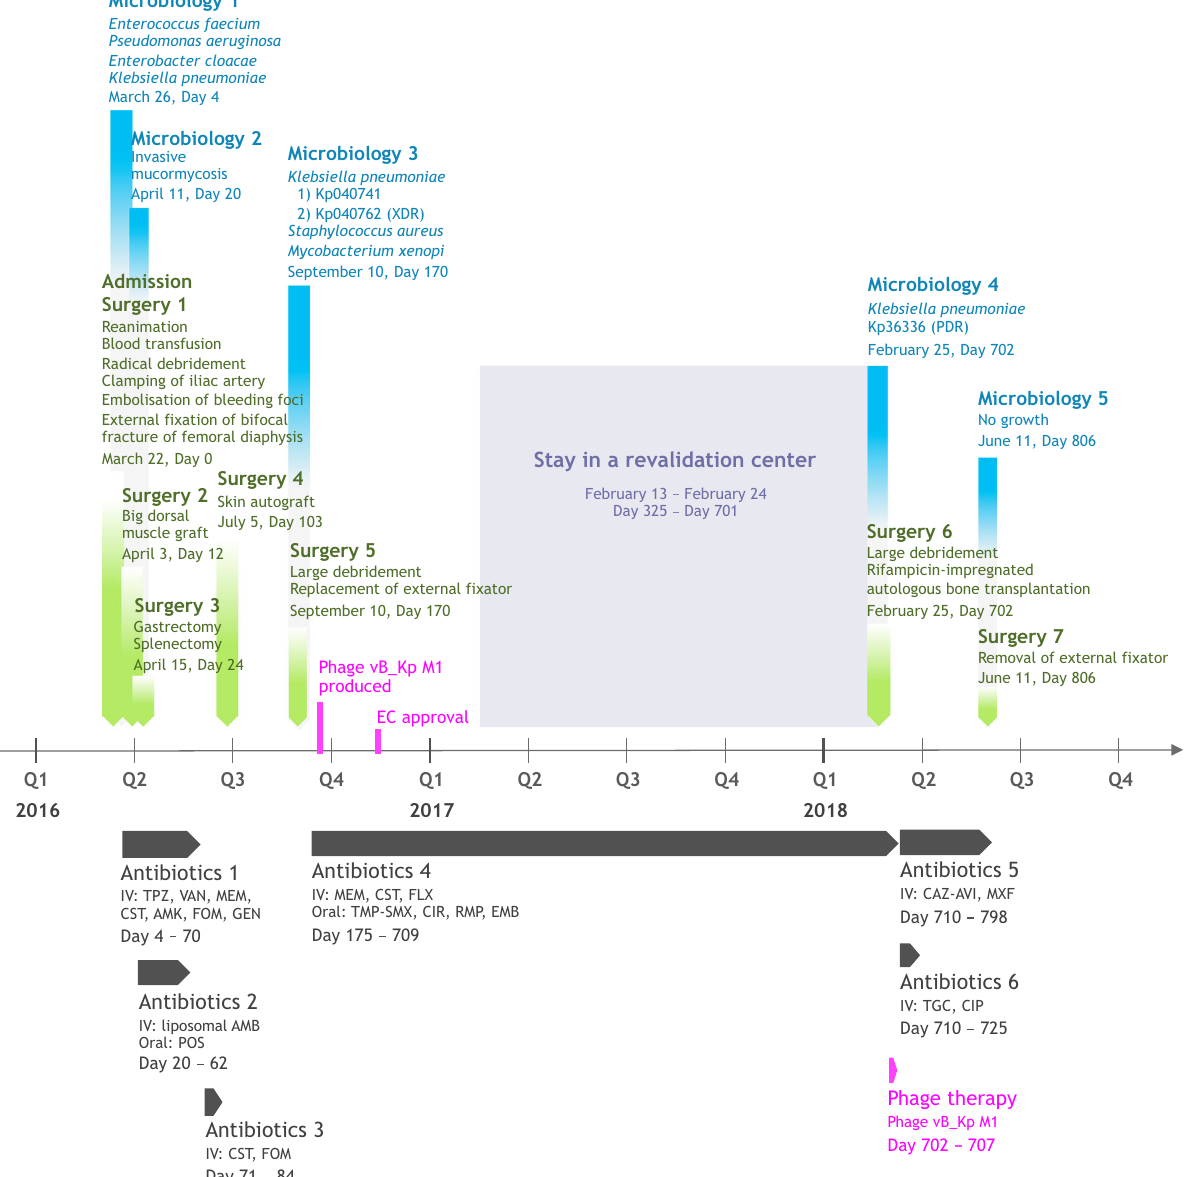
Fig. 1 Timeline of the most relevant surgical procedures (green), microbiological results (blue), antibiotic therapies (dark grey), and phage therapy (magenta). Phage therapy related events are indicated in fuchsia. AMB, liposomal amphotericin-B (600 mg, q24h); AMK, amikacin (1800 mg, q24h); CAZ-AVI, ceftazidime/avibactam (2 g/0.5 g, q8h); CIP, cipro fl oxacin (400 mg, q8h); CIR, clarithromycin (500 mg, q12h); CST, colistin (up to 20 MIU, q24h); EMB, ethambutol (1200 mg, q24h); FLX, fl ucloxacillin (2 g, q4h); FOM, fosfomycin (4 g, q4h); GEN, gentamicin (400 mg, q24h); MEM, meropenem (up to 2 g, q4h); POS, posaconazole (200 mg, q8h); TMP-SMX, trimethoprim/sulfamethoxazole (1660 mg, q12h); MXF, moxi fl oxacin (400 mg, q24h); PDR, pandrug-resistant; RMP, rifampicin (450 mg, q24h); TGC, tigecycline (100 mg, q12h); TPZ, piperacillin/tazobactam (4.5 g, q6h); VAN, vancomycin (30 mg/kg/day); XDR, extensively (IABGs) (Fig. 1). In the absence of robust pharmacological data with regard to the use of phages in FRI and without medical consensus for intravenous administration, phages were applied locally (through a catheter left in place) to obtain the highest concentration of phages at the site of infection. A short course of treatment (6 days) was chosen to minimize possible immuno- genicity and the ongoing antibiotic therapy was continued (Fig. 1).